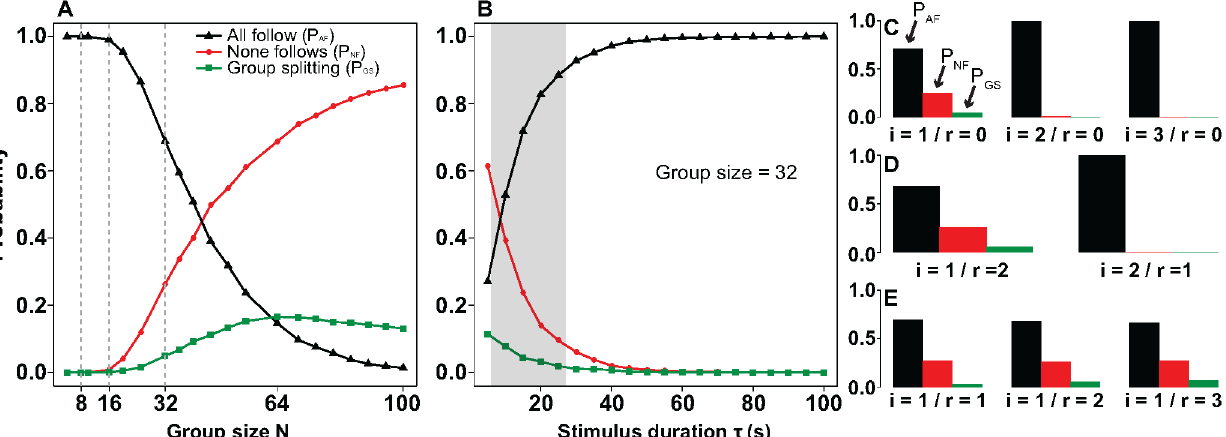
Fig 4. Model predictions for collective decision of naives. (A) Probabilities P AF of observing a full collective follow (black line), P NF corresponding to no follow (red line), and P GS to group splitting (green line) as a function of group size N for groups of naives subject to the departure of 1 initiator. (B) P AF , P NF , and P GS as function of the stimulus time, associated to the time required by the initiator to reach the target position, for N = 32 including 1 initiator. The grey area shows the interval of stimulus durations we observed experimentally. (C), (D) and (E) show P AF , P NF , and P GS when the naive group is faced to contradictory information cues: a number i of individuals determined to go towards the target (initiators) and the number r of individual determined to stay (see text for details). Results for N = 32. Notice that i and r do not induce a symmetric collective bias.